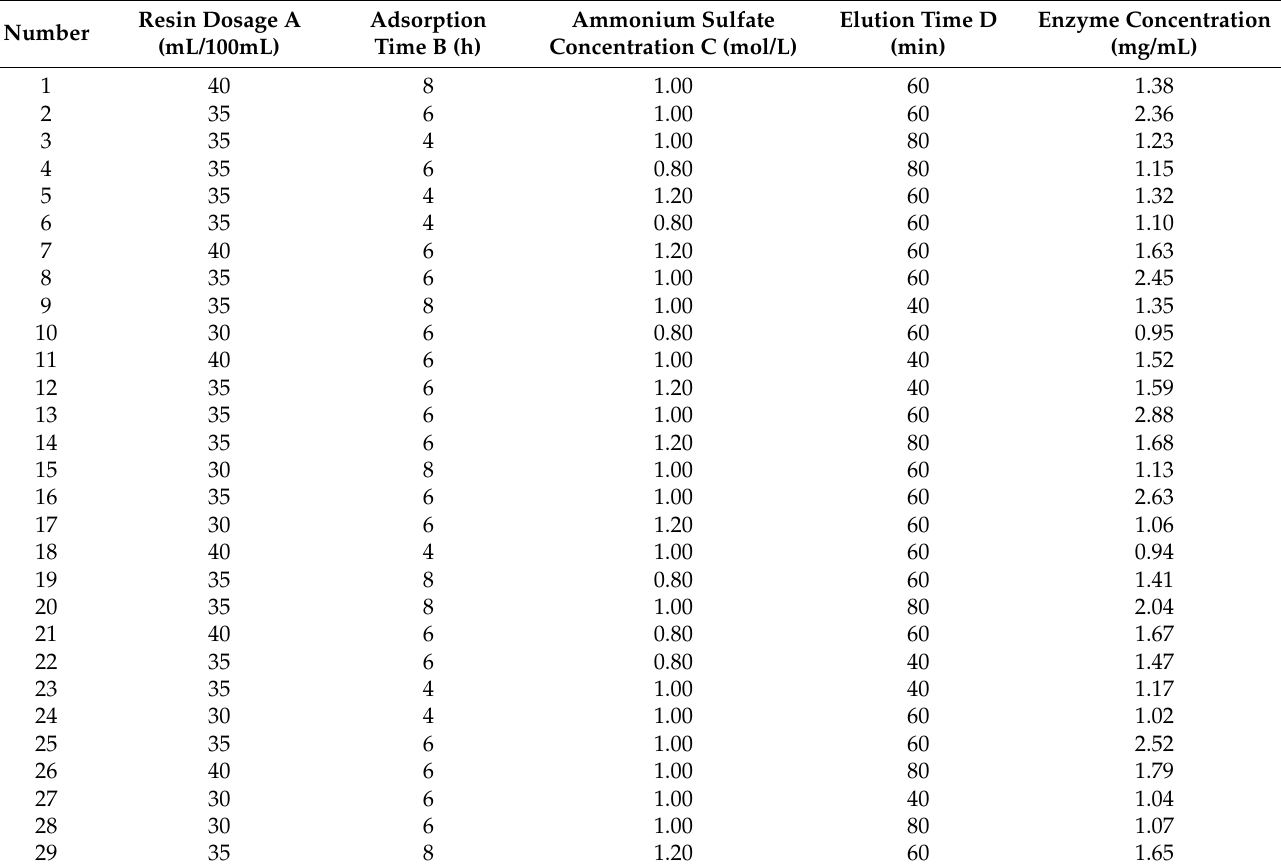
Table 2. Actual values of the factors obtained using Box–Behnken